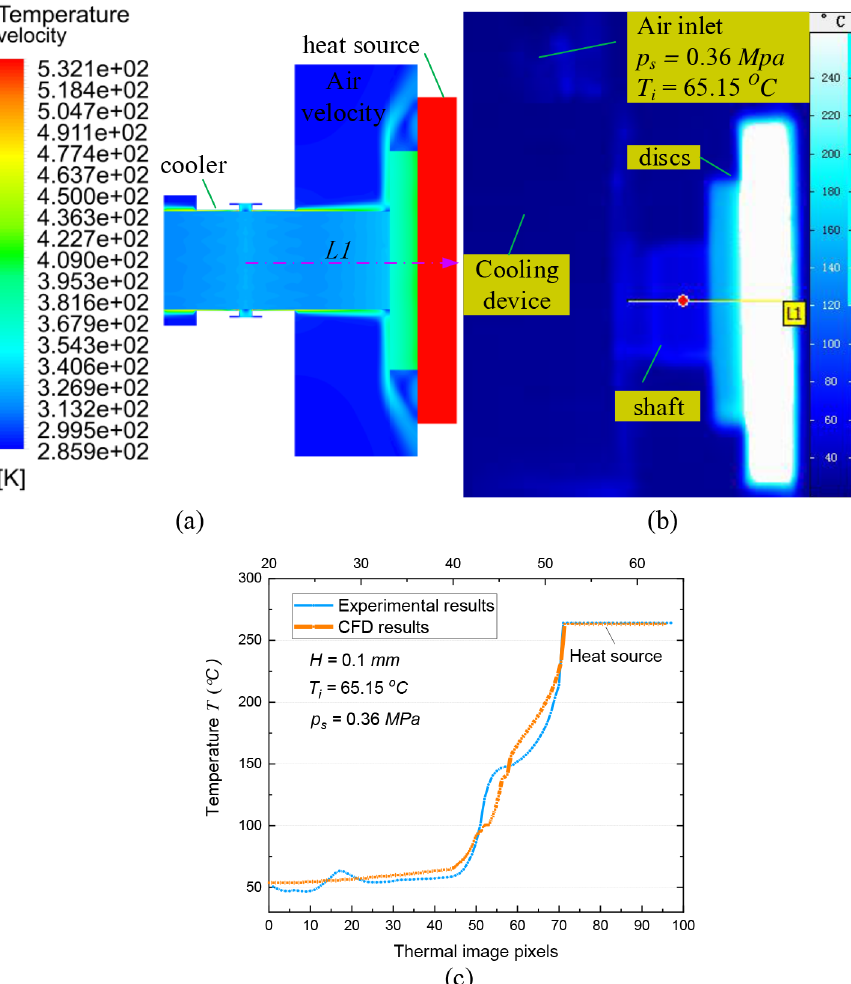
Fig. 22. Comparison of experimental data and CFD results. (a) Numerical. (b) Experimental. (c) Experimental and numerical data on line L1